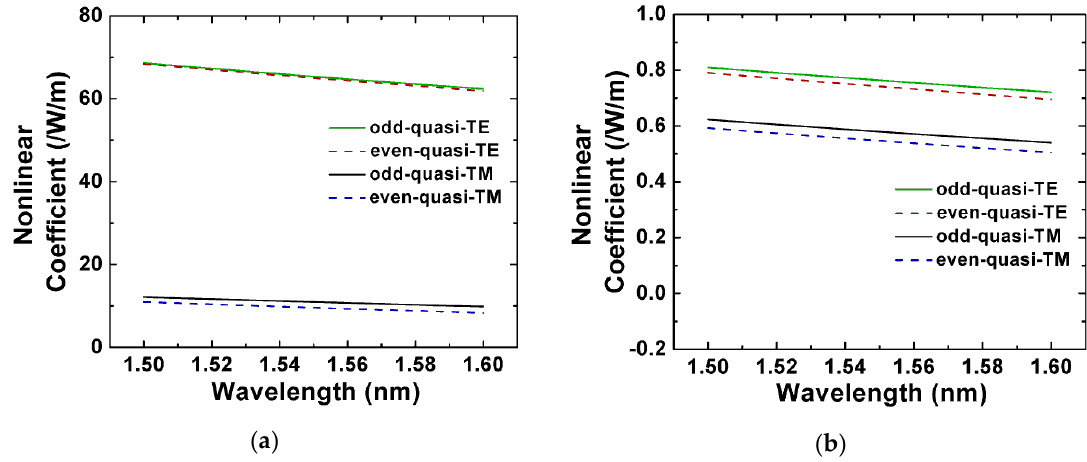
Figure 4. Nonlinear coefficient of the Si ( a ) and Si 3 N 4 ( b ) horizontal slot waveguide PBS.